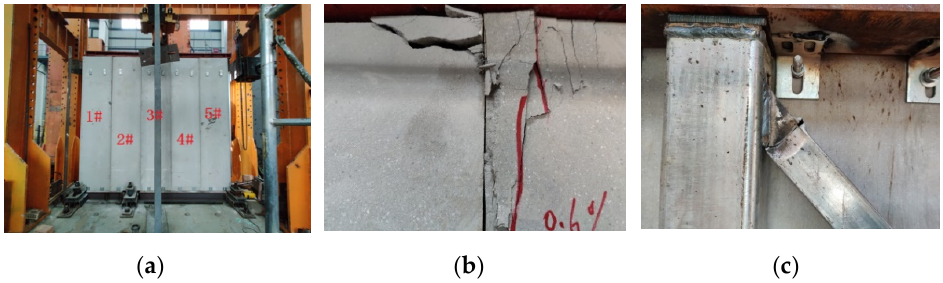
Figure 7. Test phenomena of FW-2 specimen: ( a ) Wall panel numbering sequence; ( b ) Wallboard crushed and broken; ( c ) Tearing failure at the end of the upper brace.